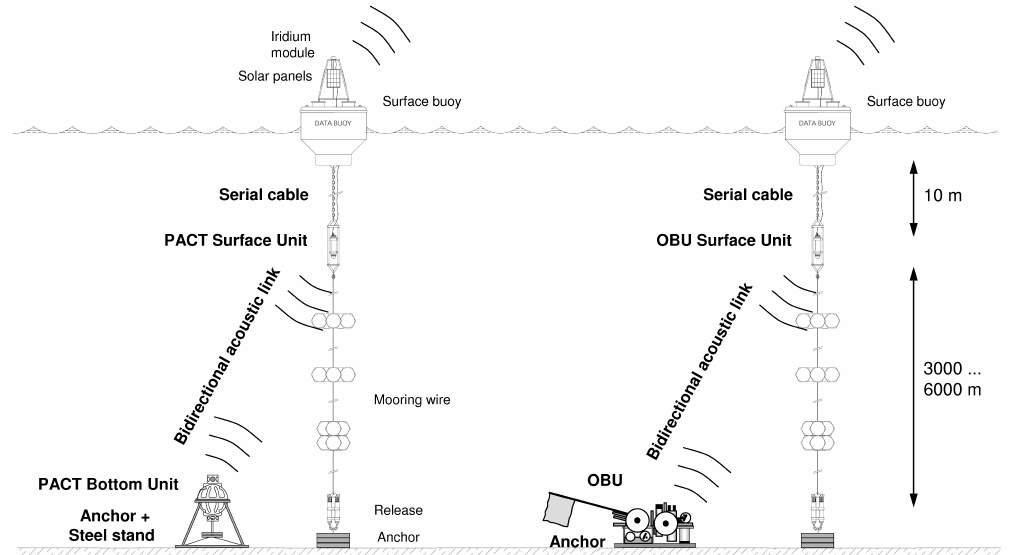
Fig. 1. Sketch of the PACT (left) and OBU (right) bottom sensor packages together with their hosting surface buoy moorings. Note that figure elements are not to